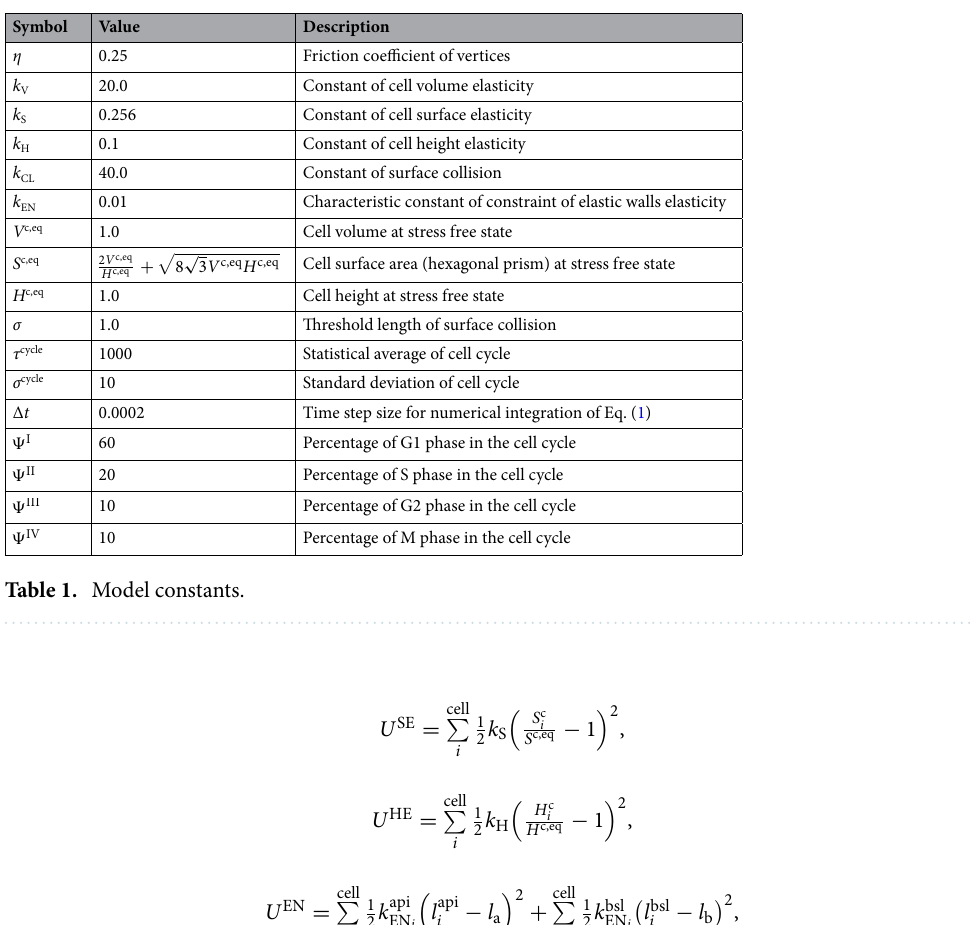
where Ʃ i cell represents summation across all cells, and l center of gravity of the i -th cell from the apical and basal surfaces, respectively. Moreover, k the elasticity coefficients of the wall on the apical and basal sides, respectively. These variables are defined as follows: